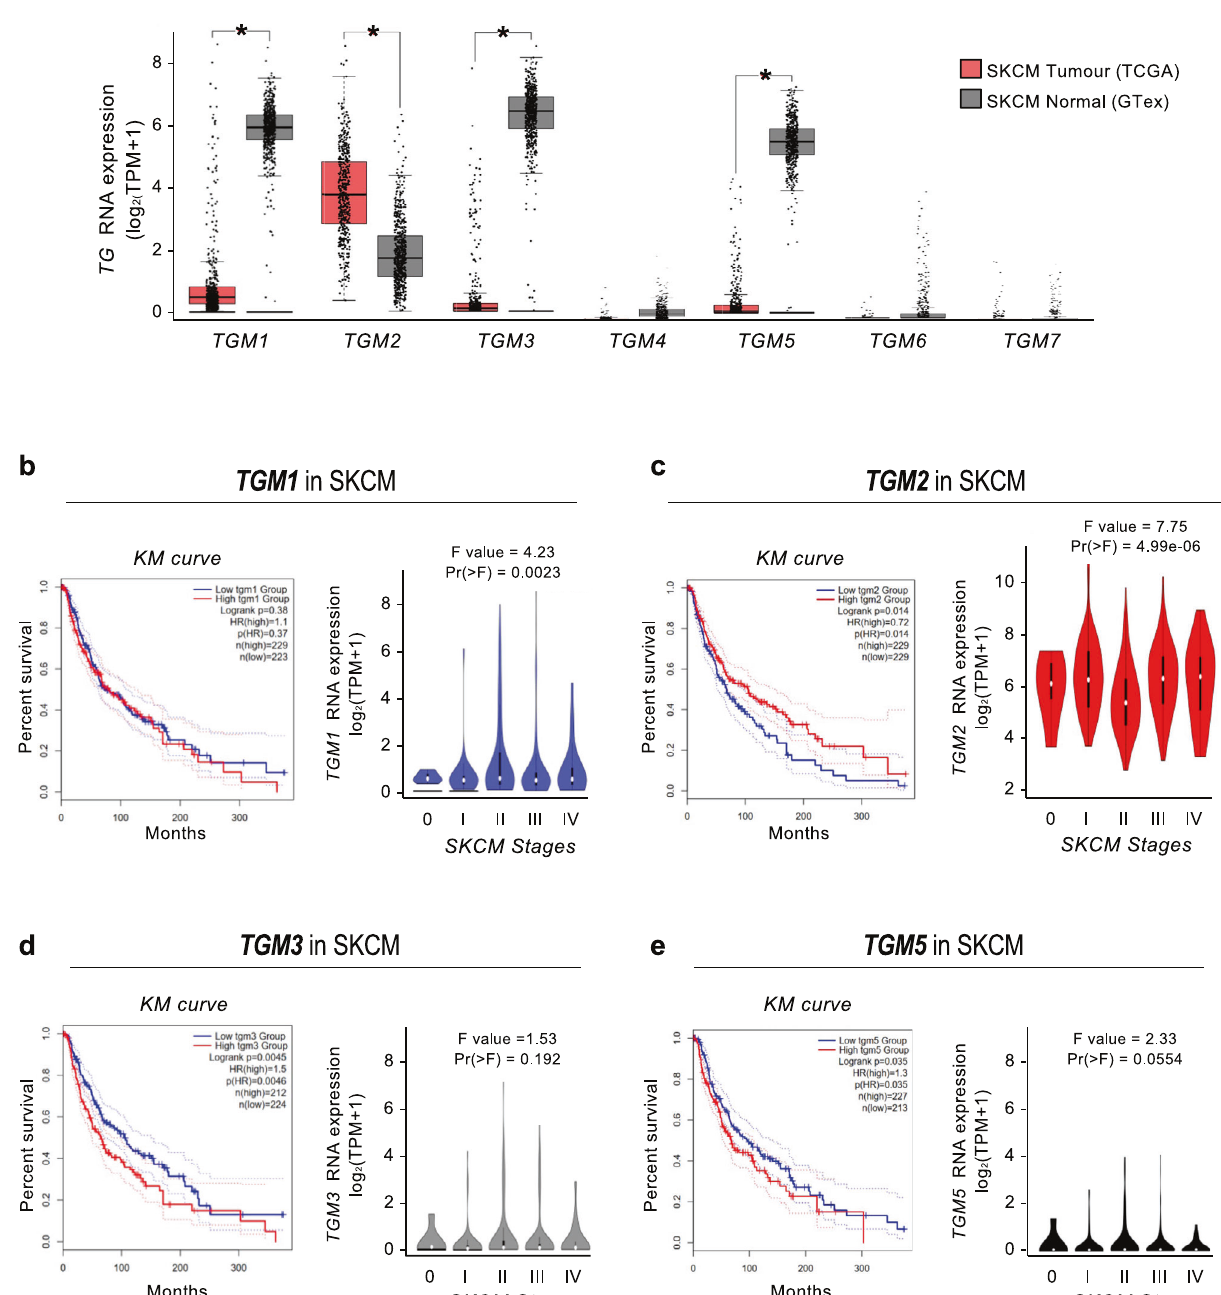
Fig. 2 Analysis of the TGs transcriptional levels and clinical value. a The mRNA expression of the seven members of the family was assessed comparing tumor and normal tissues from TCGA and GTEx datasets on the GEPIA database. Data were normalized as transcripts per kilobase million (TPM) values. TPM values were converted to log2-normalized transcripts per million [log2(TPM + 1)]. Data were shown as the mean ± standard deviation. Statistical analyses were performed using t -test. Error bars represented SD. *, **, *** indicated p -value < 0.05, 0.01, 0.001, respectively. b – e Overall survival based on TGM1 , TGM2 , TGM3 , and TGM5 expression level in SKCM was obtained through Kaplan – Meier analysis by sorting samples for high and low TG expression groups according to the median on GEPIA, as well as the expression of these TGs in the different SKCM stages. Percent survival was plotted, and p -values were shown as per fi gure speci fi cations, respectively. TGM1, TGM2, TGM3, and TGM5 mRNA expression was strati fi ed as per SKCM stages. Values were normalized as transcripts per kilobase million (TPM) values. TPM values were converted to log2-normalized transcripts per million [log2(TPM + 1)]. Statistical analyses were performed using Fisher ’ s exact test. p -values were indicated,